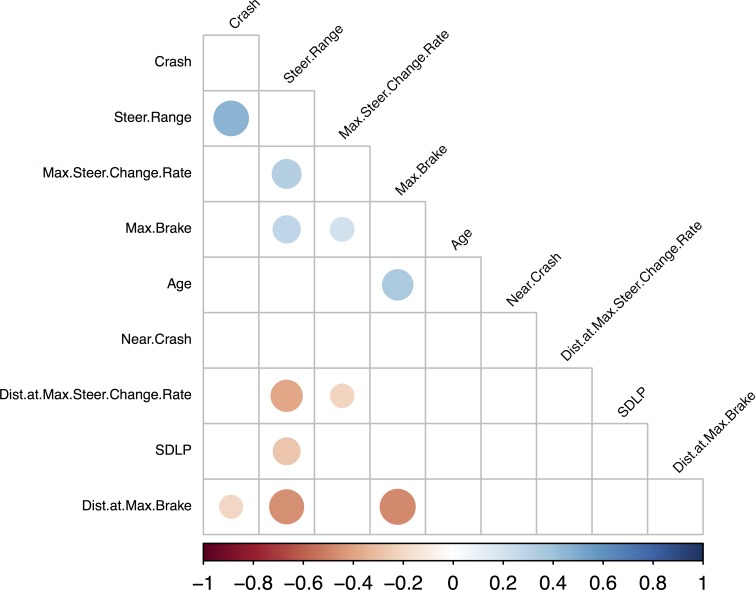
Graphical representation of the hcluster correlation analysis computed in R on the ‘Highway scenario’ dataset controlling for mean speed.Only the significant correlations (p< .05) appear on this graphical representation.